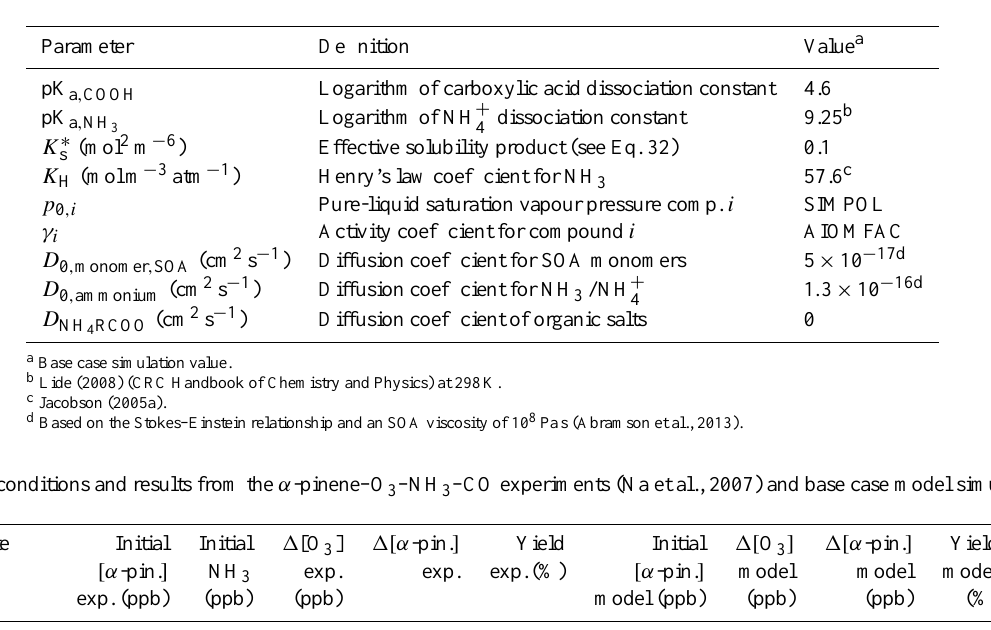
Henry’s law coefficient for NH 3